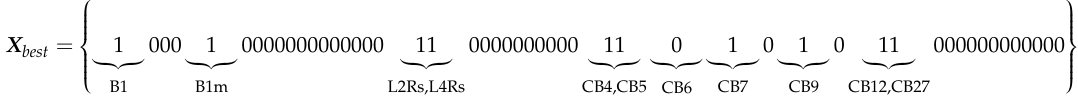
Table 2. Diagnosis results of the four-zone power system.